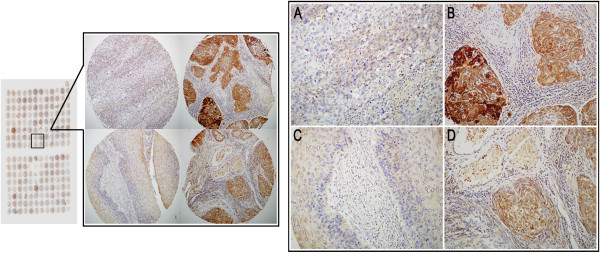
IHC staining of the NQO1 protein on tissue microarray of cervical lesions. (A) NQO1 protein was weakly positive in cervical SCC. (B) NQO1 protein showed diffuse and strong cytoplasmic-positive staining in cervical SCC. (C) NQO1 protein was negative in normal cervical epithelia. (D) NQO1 protein was positive in SCC.